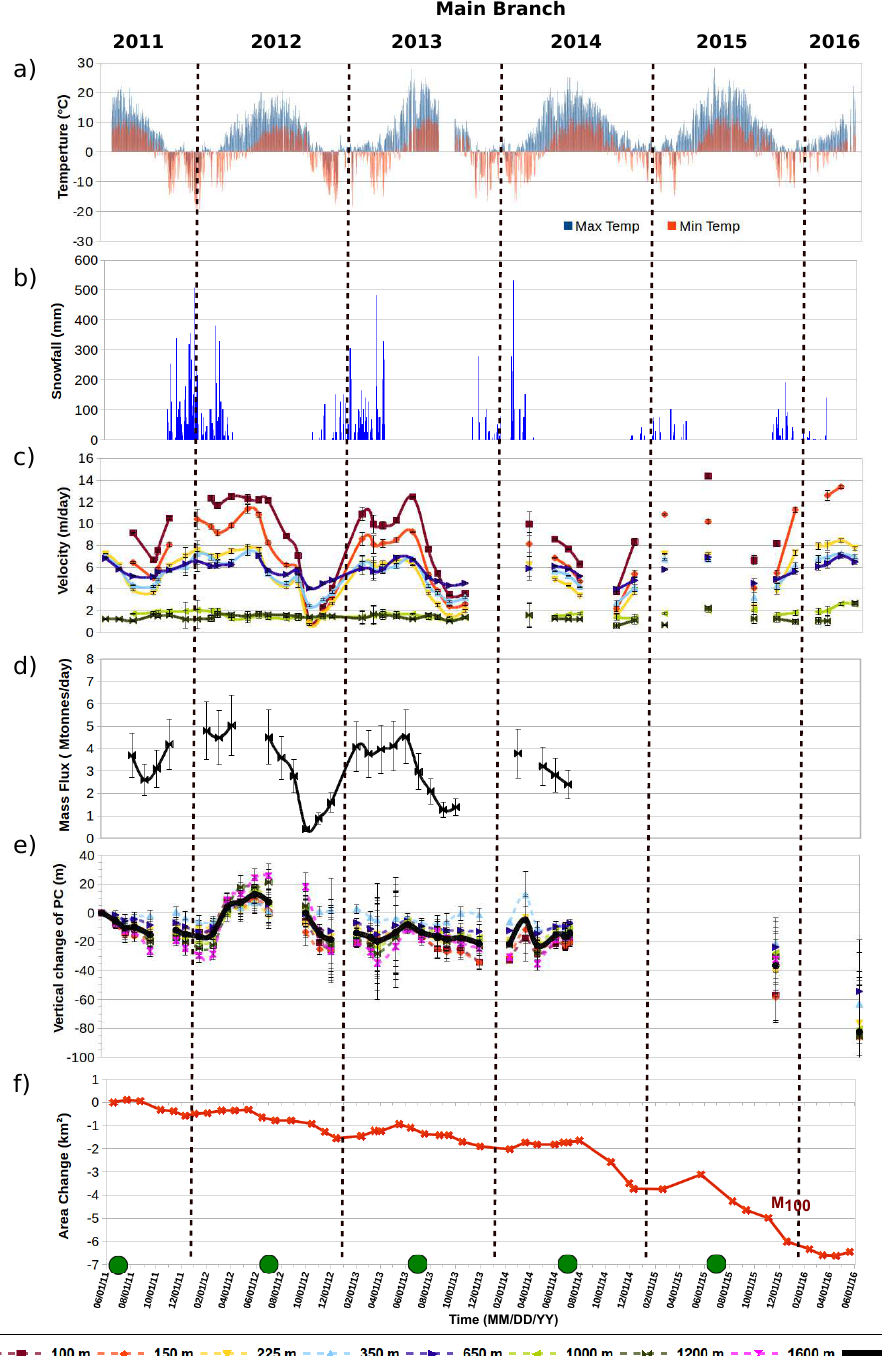
Figure 2. ( a ) Daily minimum and maximum air temperatures (Cannery Creek Weather Station) and ( b ) daily snowfall (Cannery Creek Weather Station). Temporal variation of ( c ) glacier surface velocities; ( d ) mass flux; ( e ) vertical change of the scattering phase center in regard to 06/18/2011; ( f ) area change since 06/18/2011 observed at different elevations (locations indicated in Figure 1 on the main branch Columbia Glacier, Alaska. The glacier at elevation point M 100 calved off in 2015, as indicated in panel ( c ). The green circles at the bottom axis indicate the time when the PC depicts actual surface elevation. Mass flux was estimated across the flux gate AB, shown in Figure